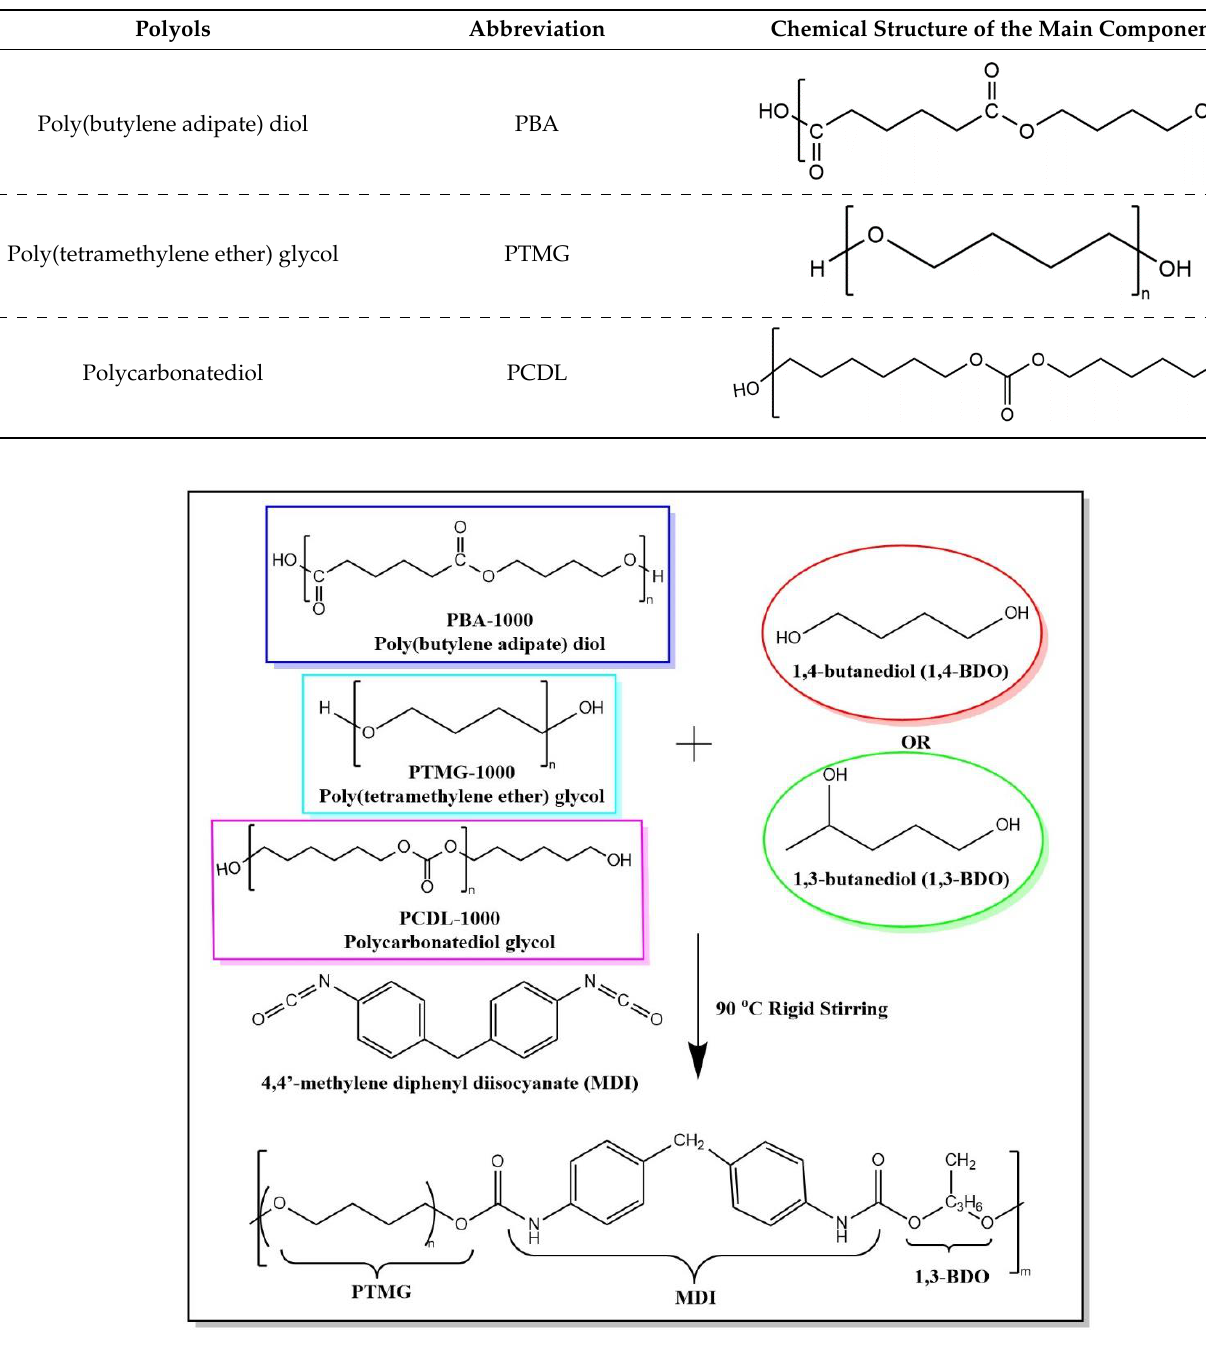
Table 1. The types of polyol used in synthesizing thermoplastic polyurethanes (TPUs).